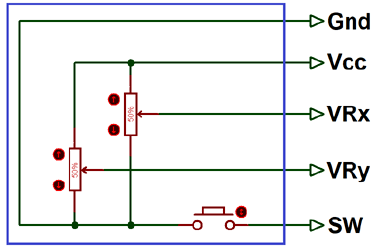
Fig. 7. Schematic diagram of joystick module